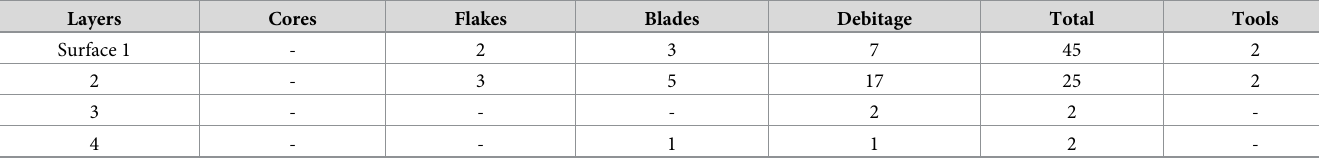
Table 6. Lithic assemblages from zone 5. Surface layer 1 is a mix of Holocene and Gravettian finds. Layer 2 dates to the Gravettian. Layer 3 is slightly earlier than layer 2 and could belong to an Aurignacian context. Layer 4 dates into the Middle